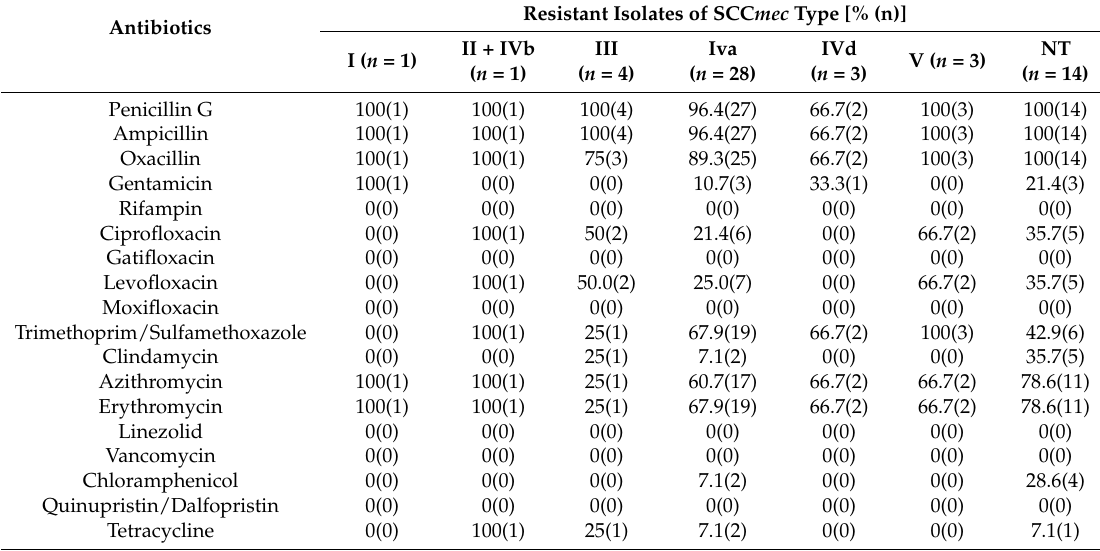
Table 2. Resistance profiles of 54 MRSE isolates with different staphylococcal cassette chromosome mec (SCC mec ) types.